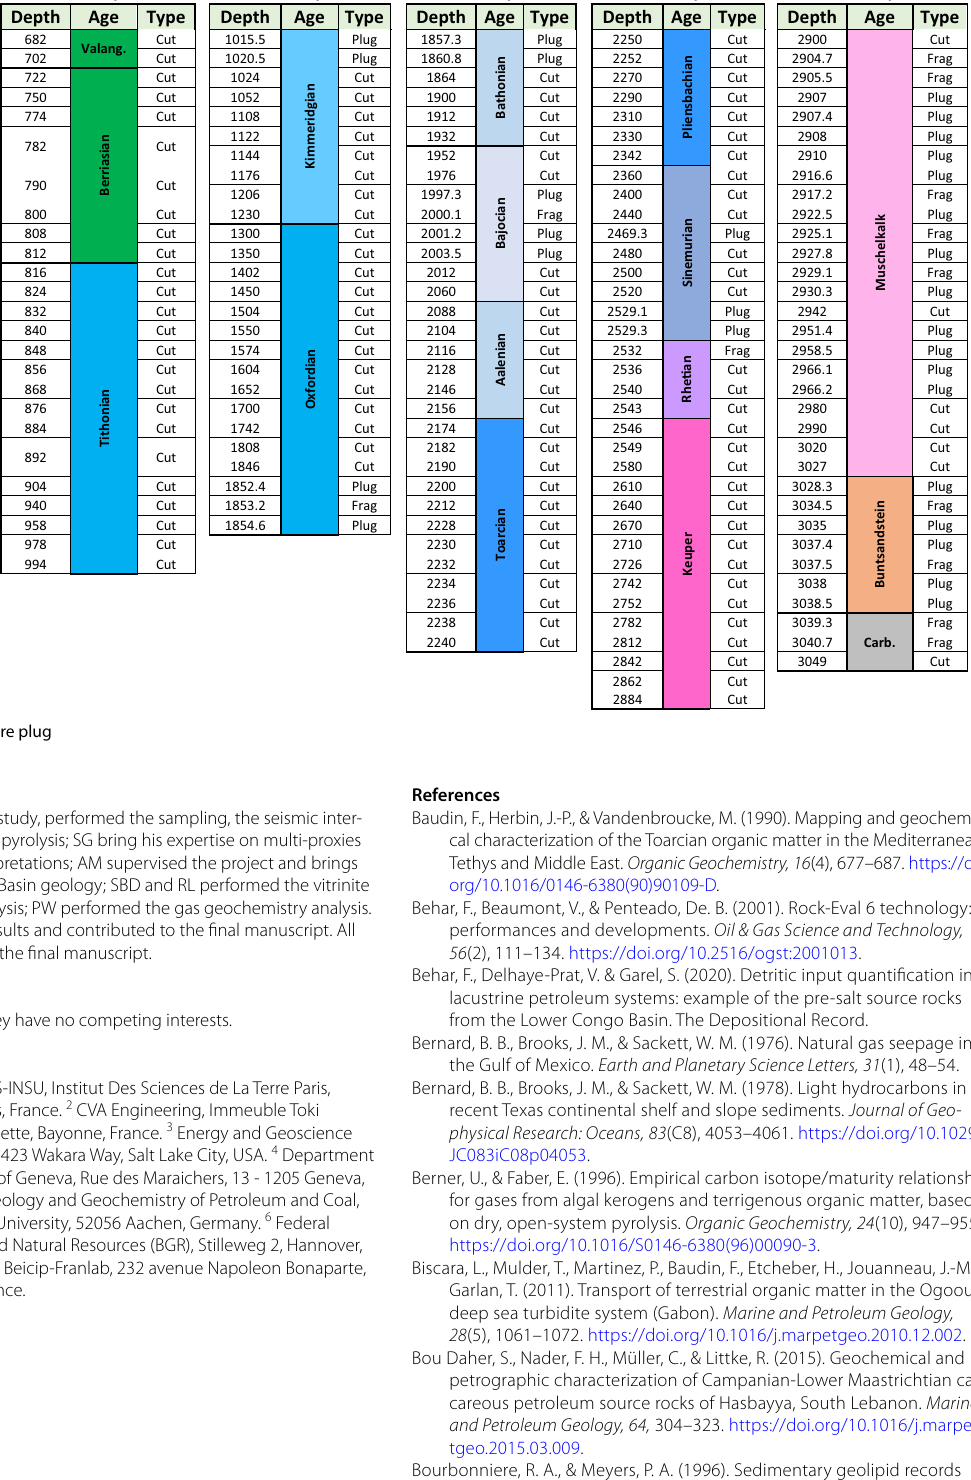
Table 6 List of the sampled intervals in the various wells of the study area